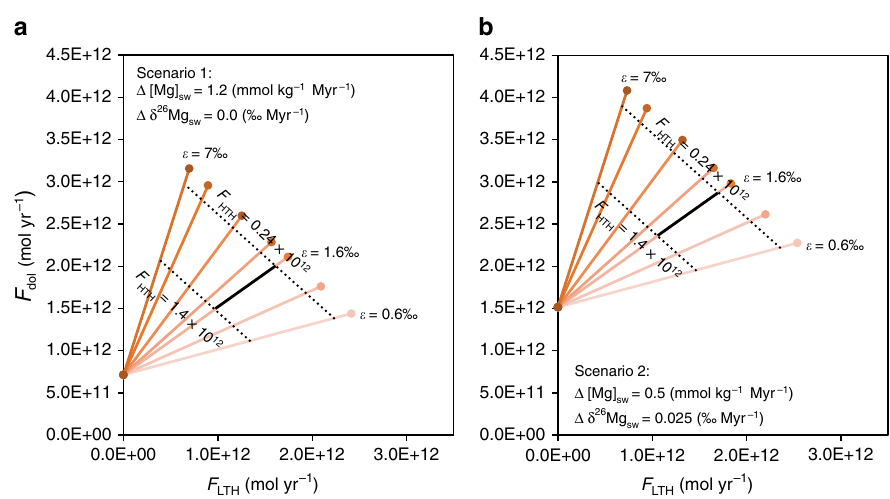
Fig. 5 Results of Mg budget calculations. The calculations are done by Eqs. (3) and (4). The solid black line shows the calculated Mg fl ux into the dolomite sink, F dol , and the low-temperature hydrothermal (LTH) sink, F LTH , given the isotope fractionation by the LTH system, ε LTH-sw , is 1.6 ‰ and the Mg fl ux into the high-temperature hydrothermal (HTH) sink, F – 1.4 Tmol yr − 1 . The orange lines show the results for different ε HTH , is in the range of 0.24 LTH-sw values in the range of 0.6 – 7 ‰ (shown: 0.6, 1, 1.6, 2, 3, 5, 7 ‰ ). The black-dotted lines de fi ne the possible range of F dol and F LTH given the allowed range in − 1 in Myr) with no change in seawater δ 26 Mg. This F HTH . Two extreme scenarios are presented, equivalent to: ( a ) a rapid increase in [Mg] sw (1.2 mmol kg scenario results in minimum output fl uxes; and ( b ) a slow rise in [Mg] sw (0.5 mmol kg − 1 in Myr) and larger changes in seawater δ 26 Mg (0.025 ‰ Myr − 1 ). This scenario results in maximum output fl